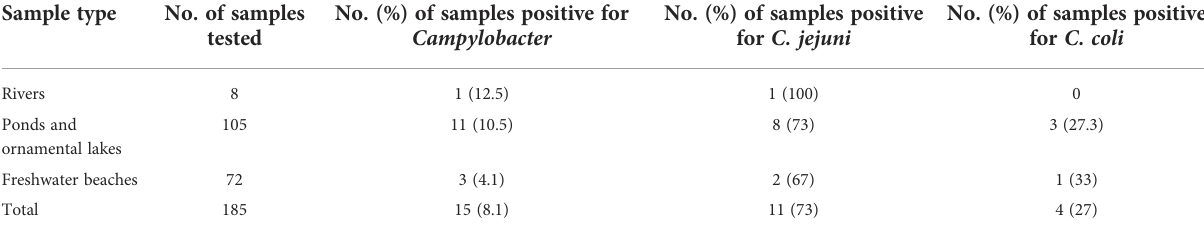
TABLE 2 Prevalence of Campylobacter isolated from surface water samples in Poland between 2017-2020.